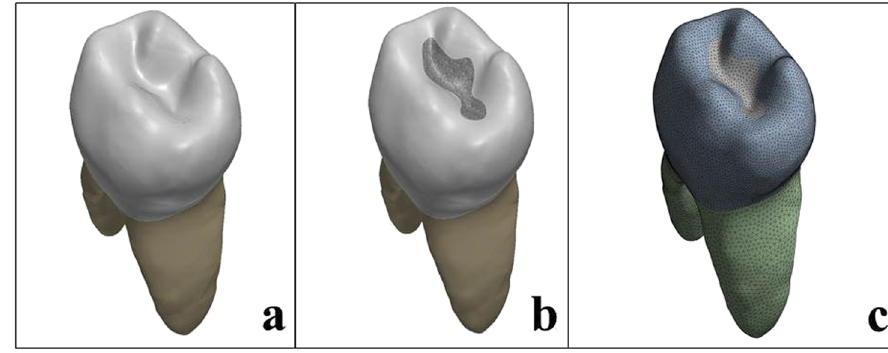
Figure 1: Model 1 and Model 2: ( a ) Model 1: tooth model without restoration ( control group ) , ( b ) Model 2: tooth model with Class I restoration and ( c ) meshed